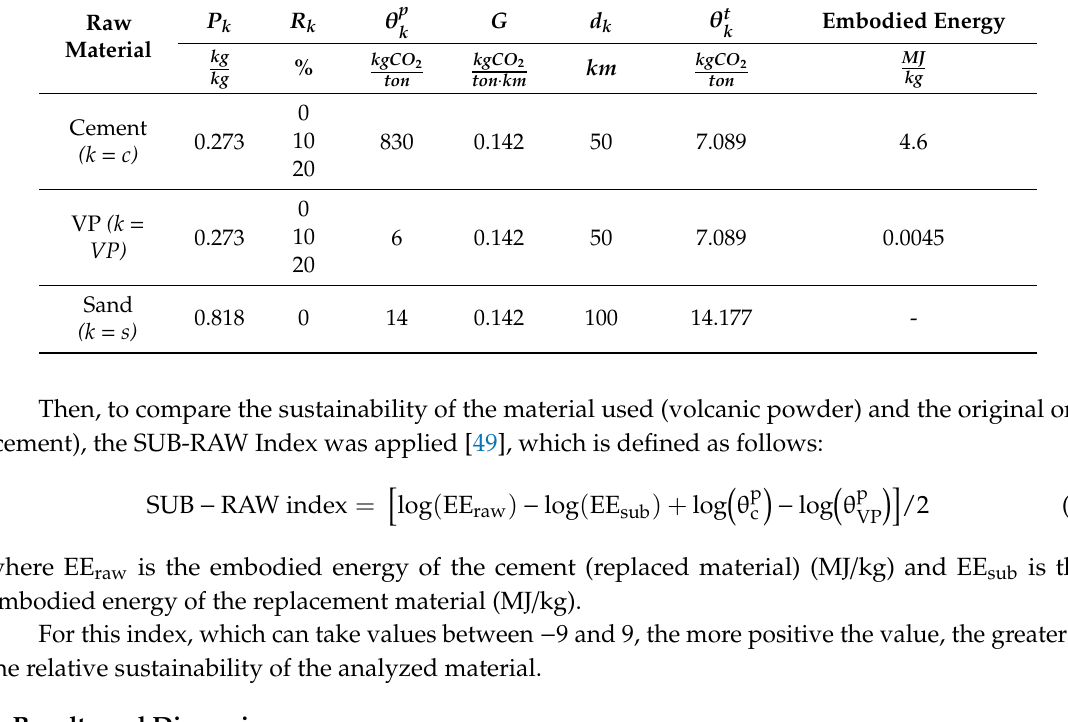
Table 2. Factors used to calculate the greenhouse gas (GHG)